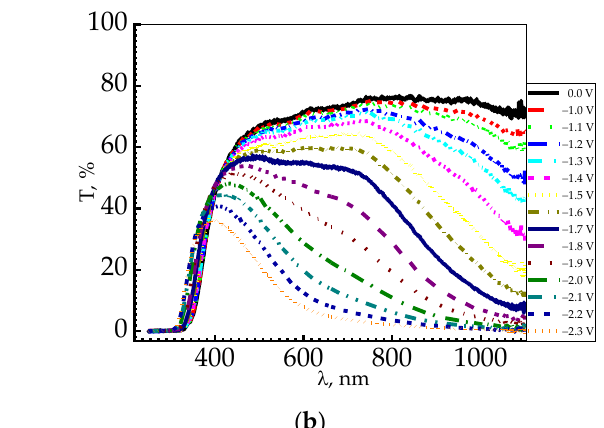
Substrate In O (ITO) 2 3 Ion conductor (electrolyte) EC In O (ITO) 2 3 Substrate